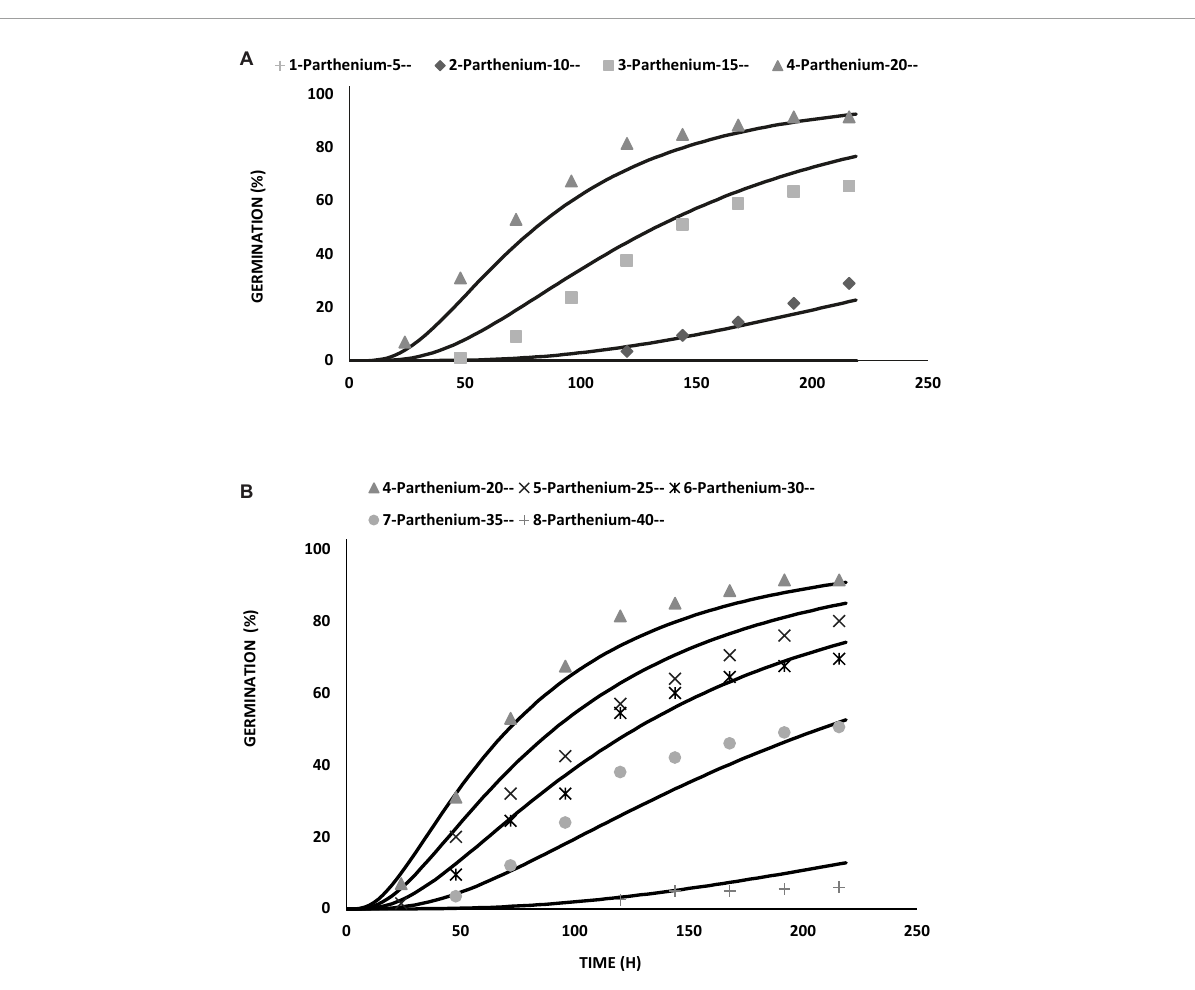
FIGURE2 Germination curve for Parthenium hysterophorus seeds at suboptimal (A) and supraoptimal (B) temperatures by using thermal time modeling approach under controlled environment (lab conditions).